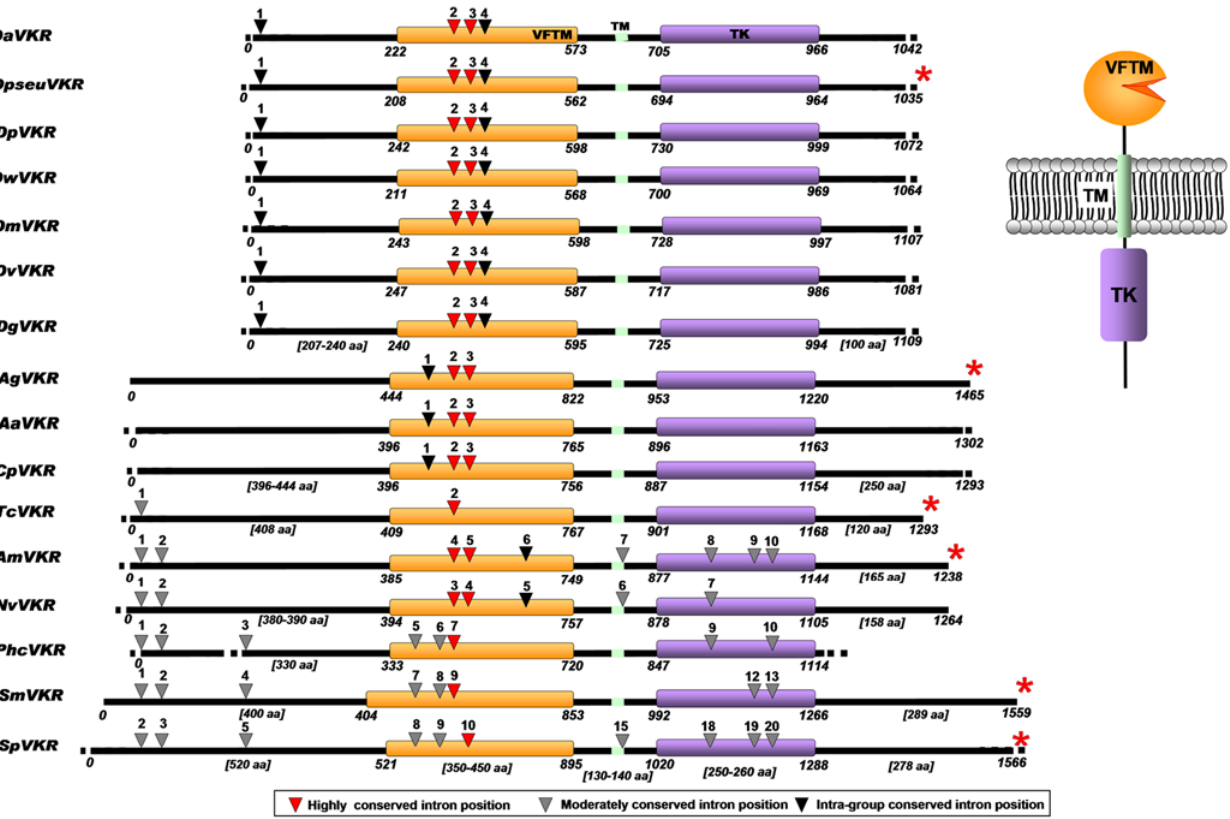
Figure 3. Conserved structure of receptors composing the VKR family. VFTM, TM and TK domains are respectively shown in orange, green and purple. Arrows give the positions of conserved introns in the different sequences with their corresponding numbers in each sequence. The different colors used for arrows indicated variable degrees of conservation for intron positions, as mentioned. The positions of residues delimiting the different domains are indicated by numbers. Red asterisks correspond to VKR for which cDNAs were cloned and sequenced.